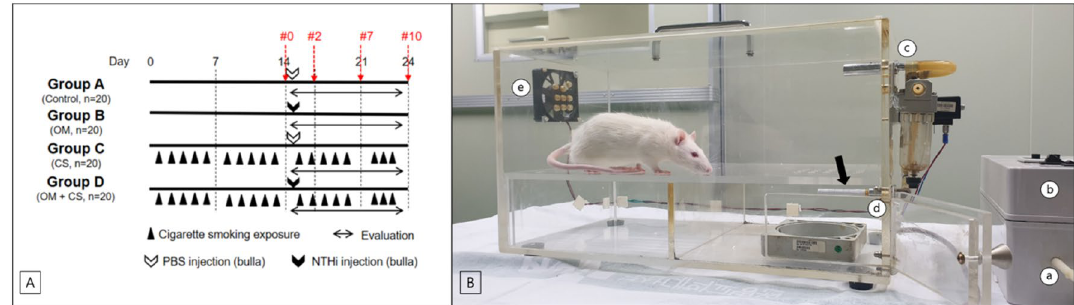
Figure 8. ( A ) Experimental protocol for generating the rat models of otitis media (OM), cigarette smoke (CS), and otitis media + cigarette smoke (CS + OM). ( B ) Experimental equipment used for CS exposure. The experimental animals are exposed to both mainstream and sidestream CS. a. Animal ventilator; b. interval controller; c. mainstream smoke; d. sidestream smoke; e. window; black arrow,